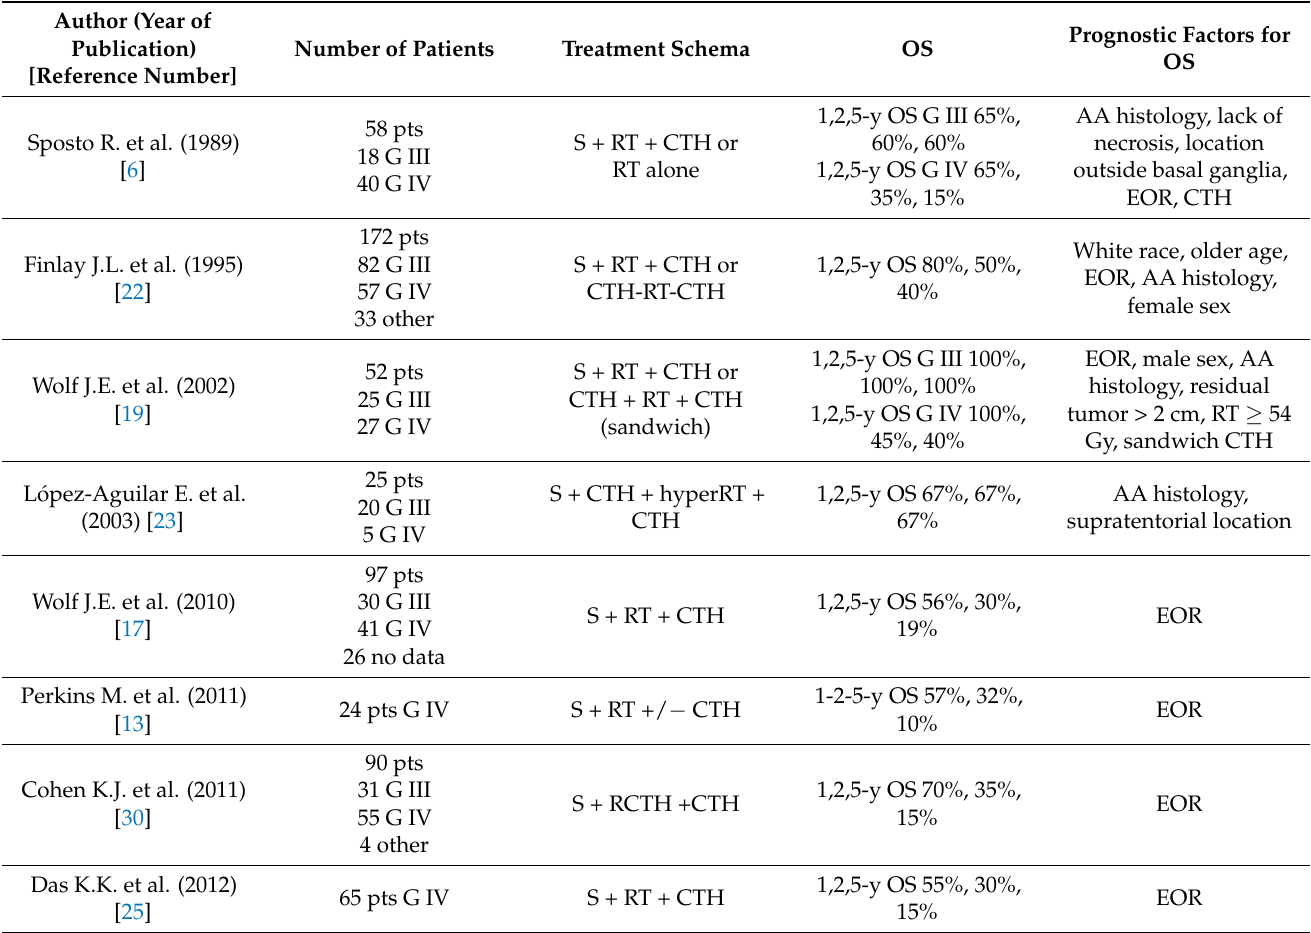
Table 4. Pediatric high-grade gliomas-prognostic